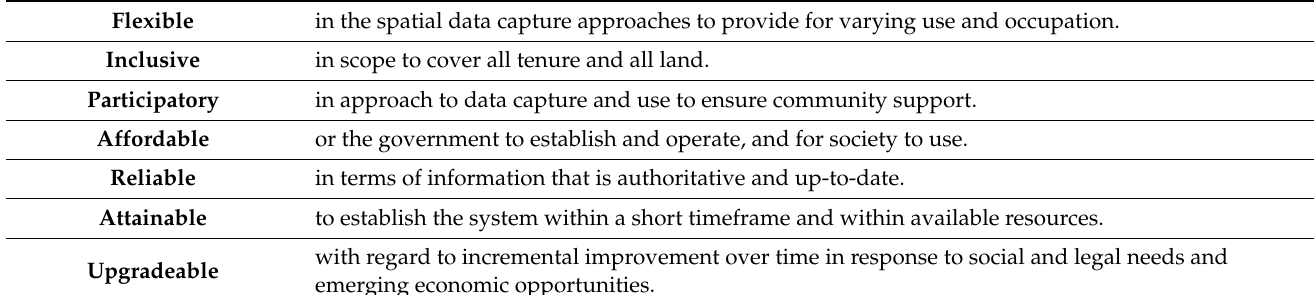
Table 1. Characteristics of the FFP Approach